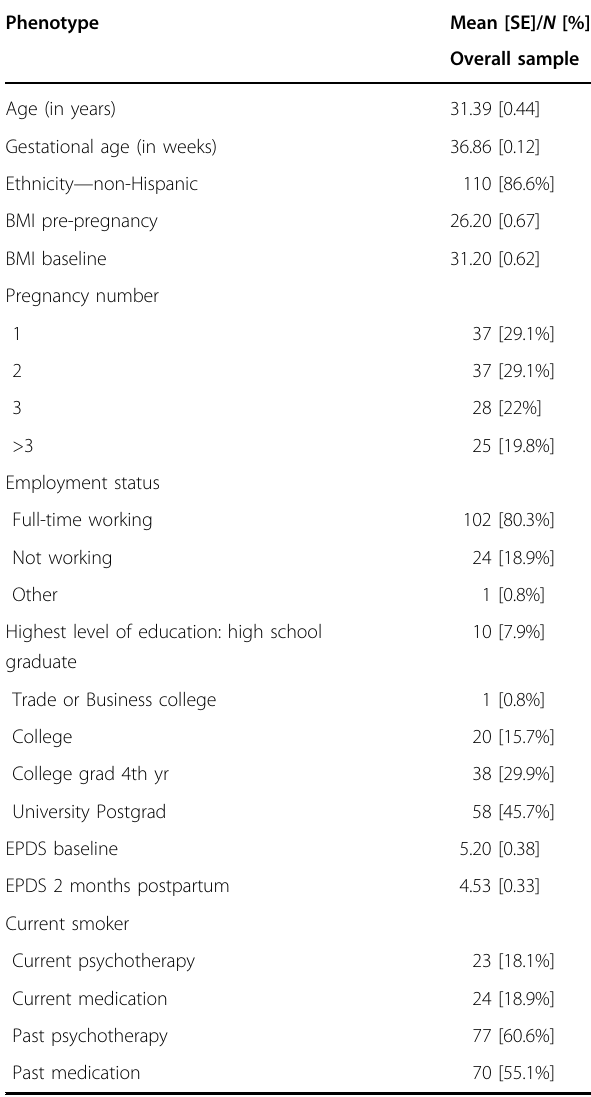
Table 1 Demographics and clinical characteristics of the samples included in the study.